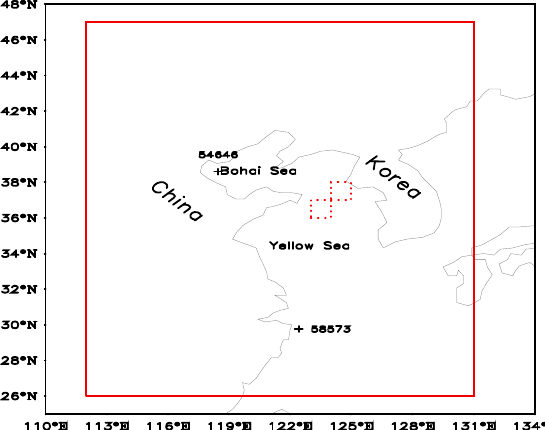
Figure 1. Map of the study area. The large square indicates the simulation domain with 3 km resolution. The two small squares indicate the analysis area of humidification effects. + denotes the observational stations 54646 and 58573.